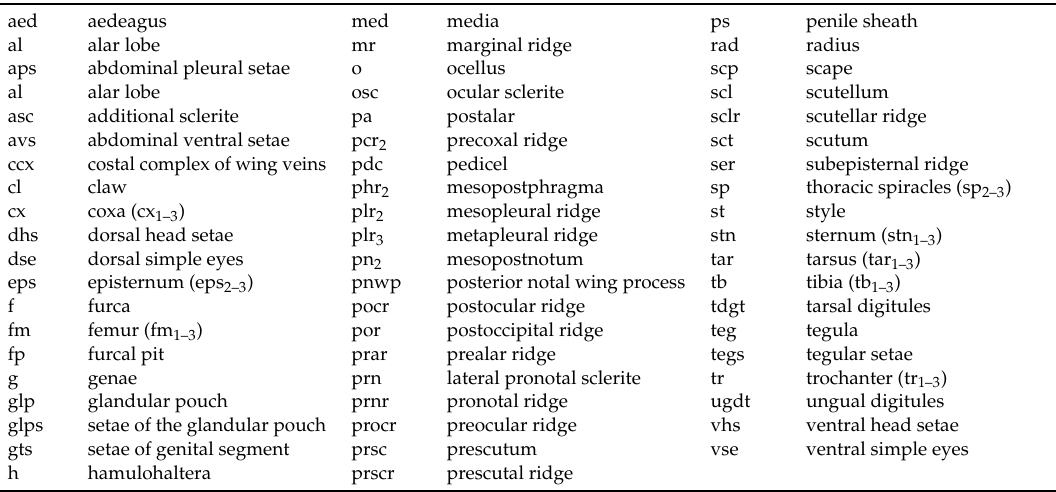
Table 1. List of abbreviations used to refer to structures of male Allokermes galliformis (Riley, 1881).